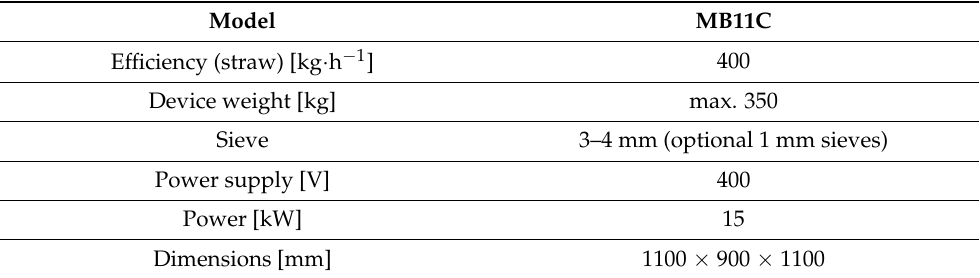
Table 2. The technical specifications of the MB11C mill.